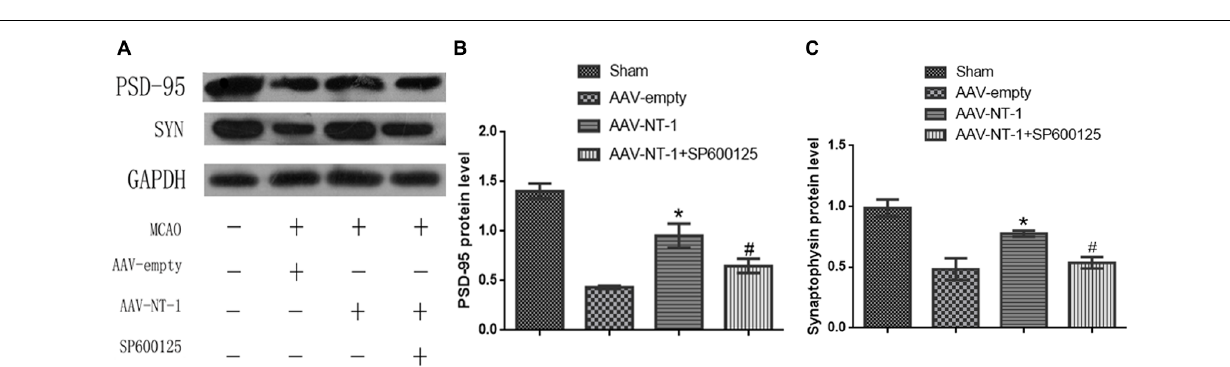
( Figure 7I ) was found among the groups. Taken the